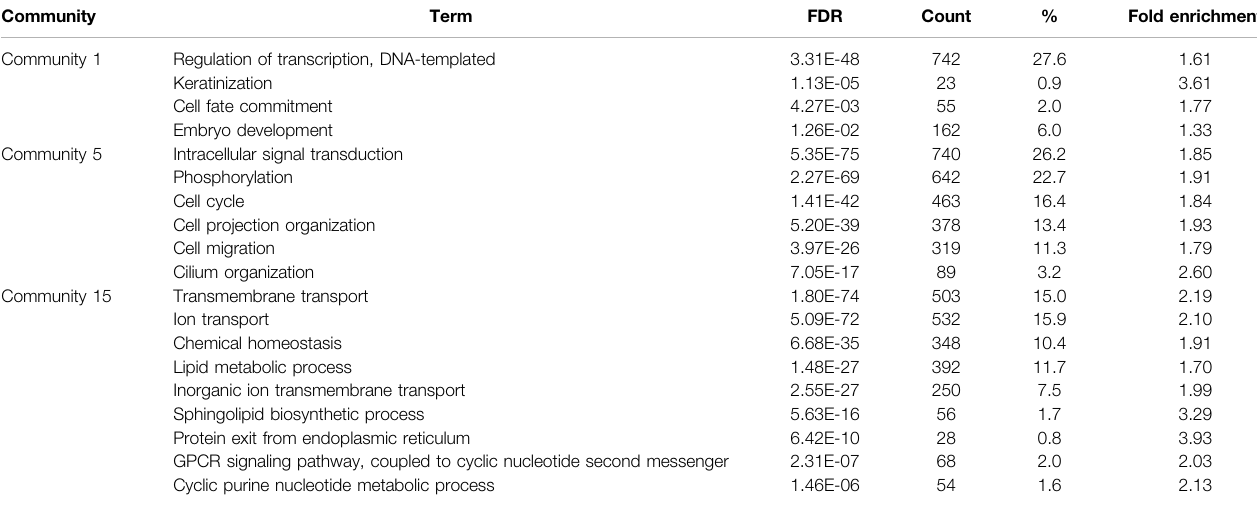
FIGURE 3 | and the HDG subset of nodes (Sets 1,2 and 3, respectively – see Table 2 for more details). (B) shows the topological properties of both the HDG and non- HDG relative tothe complete network where topological propertiesin red indicate an increasecompared tothe whole network and those in blue adecrease. (C) . Part C shows the percentage of the entire HPPI, the HDG and its MIE subset that maps to each of these communities. The inset heatmap shows the over- and under- representation of the HDG subsets relative to the HPPI.